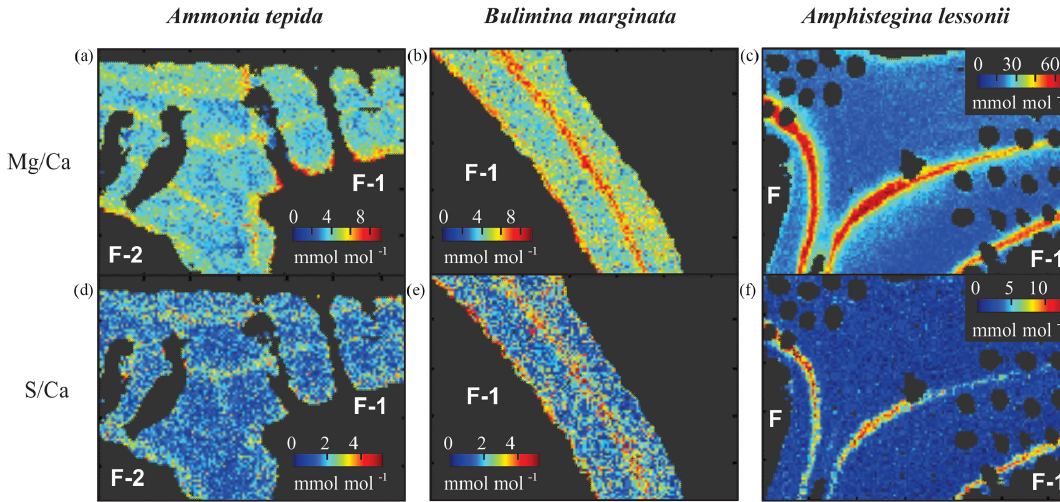
Figure 5. Typical distribution of Mg / Ca (a, b, c) and S / Ca (d, e, f) in three species of foraminifera, Ammonia tepida (a, d) , Bulimina marginata (b, e) and Amphistegina lessonii (c, f) . Chamber numbers are indicated in white on the interior part of the shell.